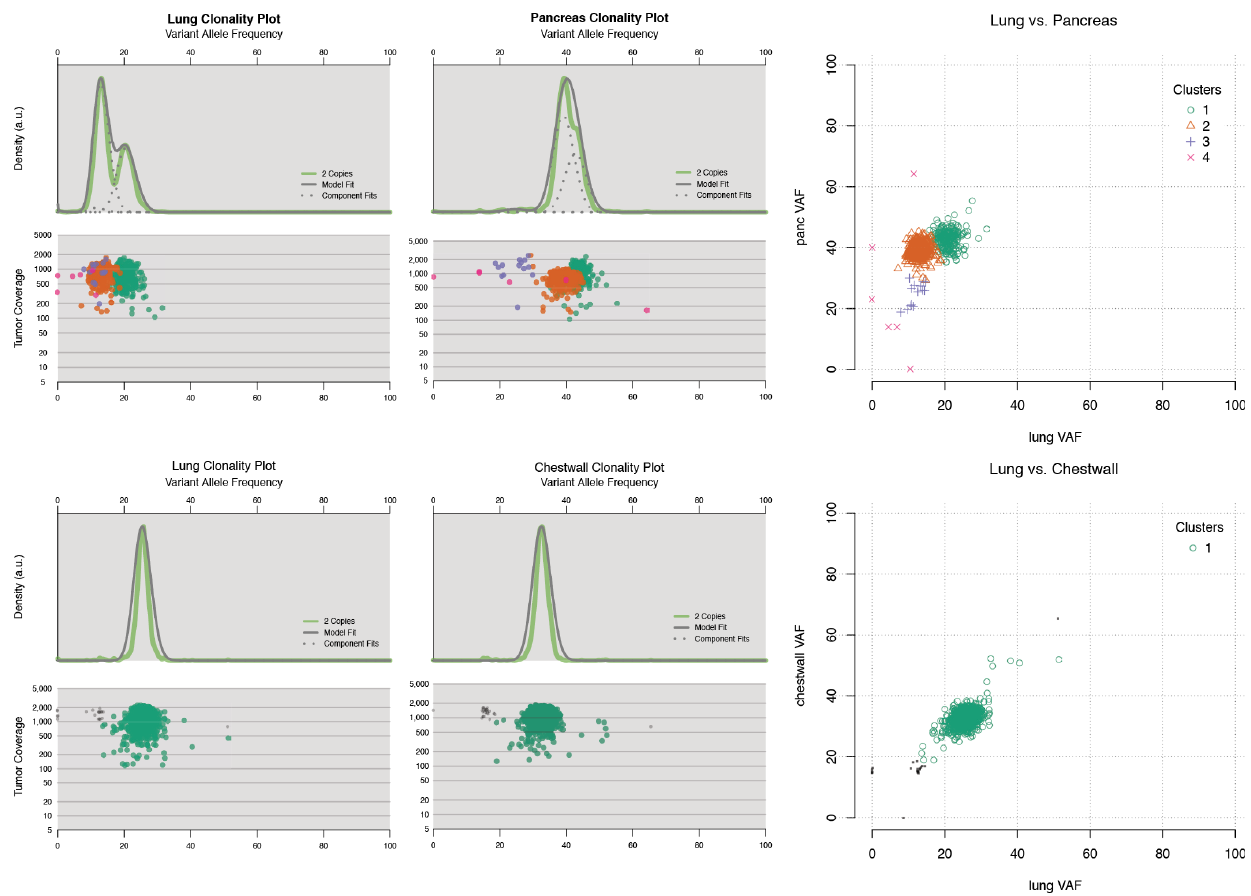
Figure 6. Comparison of clonality patterns of metastatic samples from two tissue sites of the same individuals (MEL5 and MEL13). Kernel density and variant allele frequency by sequence depth plots for each metastasis in MEL5 and MEL13. Data shown are from chromosomes 17, 18, and 21 for MEL5, and from chromosomes 3, 7, and 14 for MEL13. The plots indicate multiple clones in MEL5 with enrichment from lung to pancreas in MEL5, and nearly identical clonal pattern in both metastases in